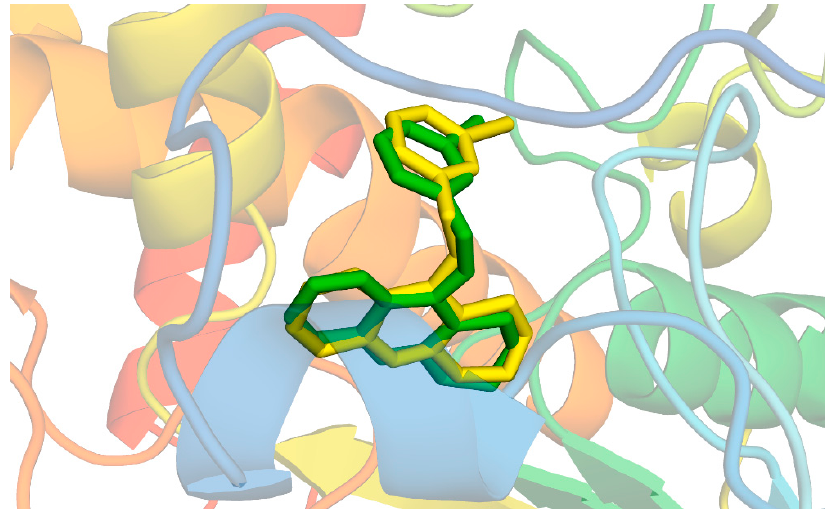
Figure 2. Superposition of crystallographic (green) and redocked (yellow) ligands.